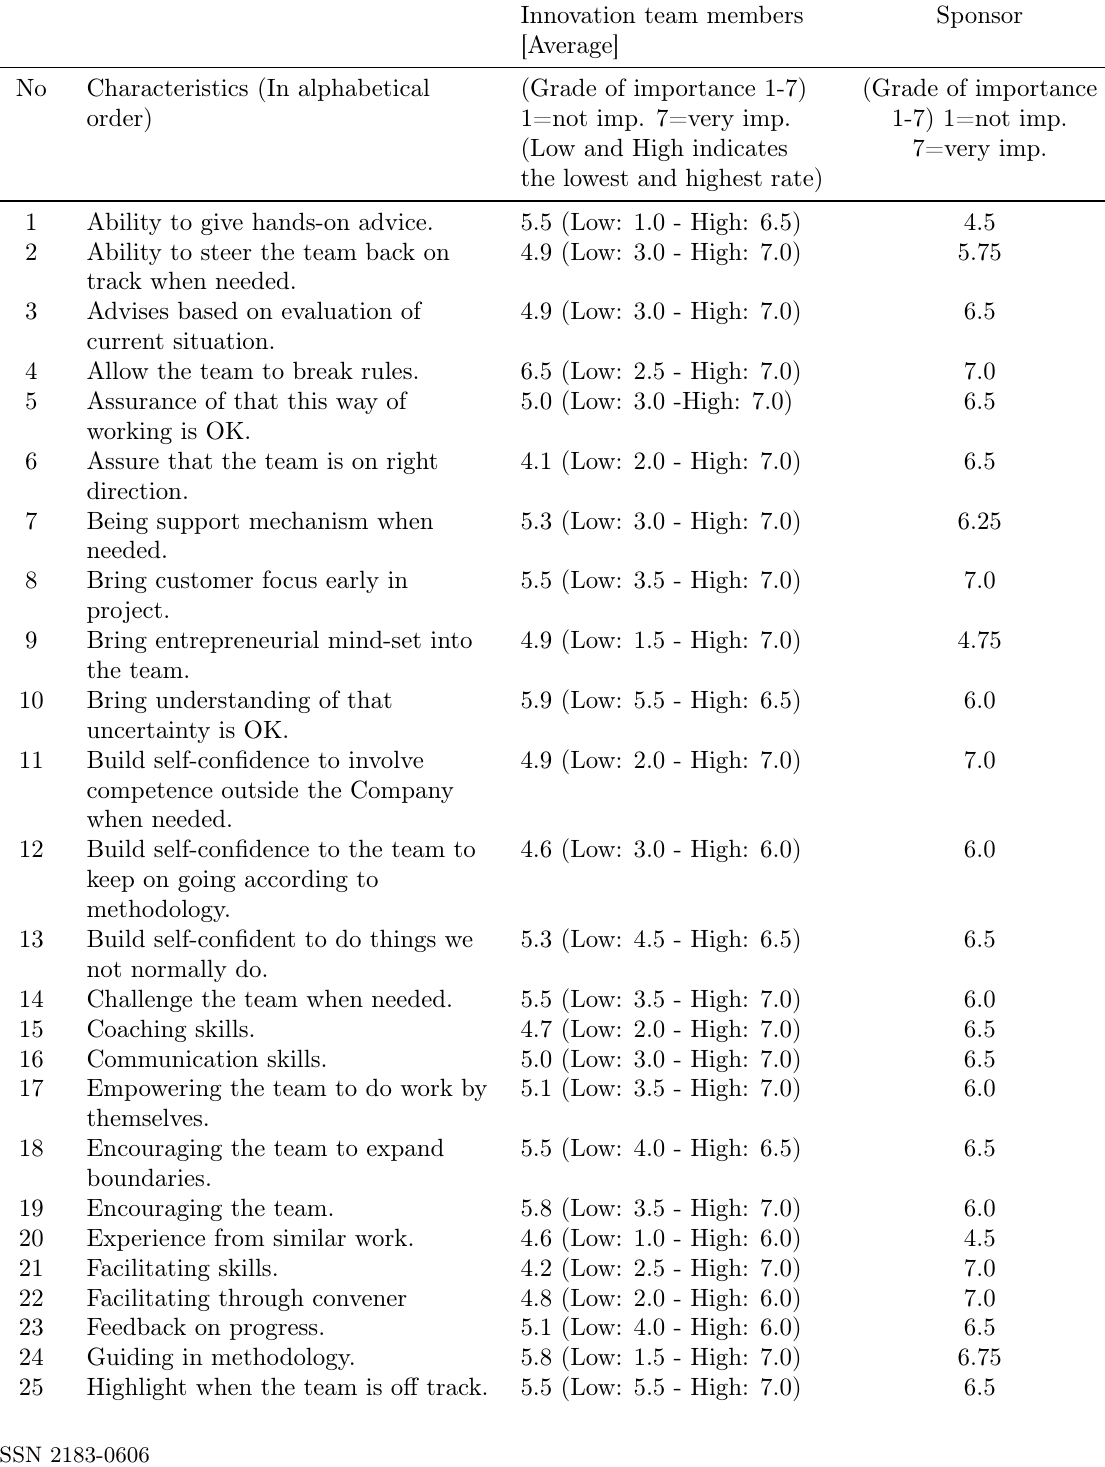
Table 2 . The table demonstrates how important the facilitator’s characteristics are according to the innovation teams and the